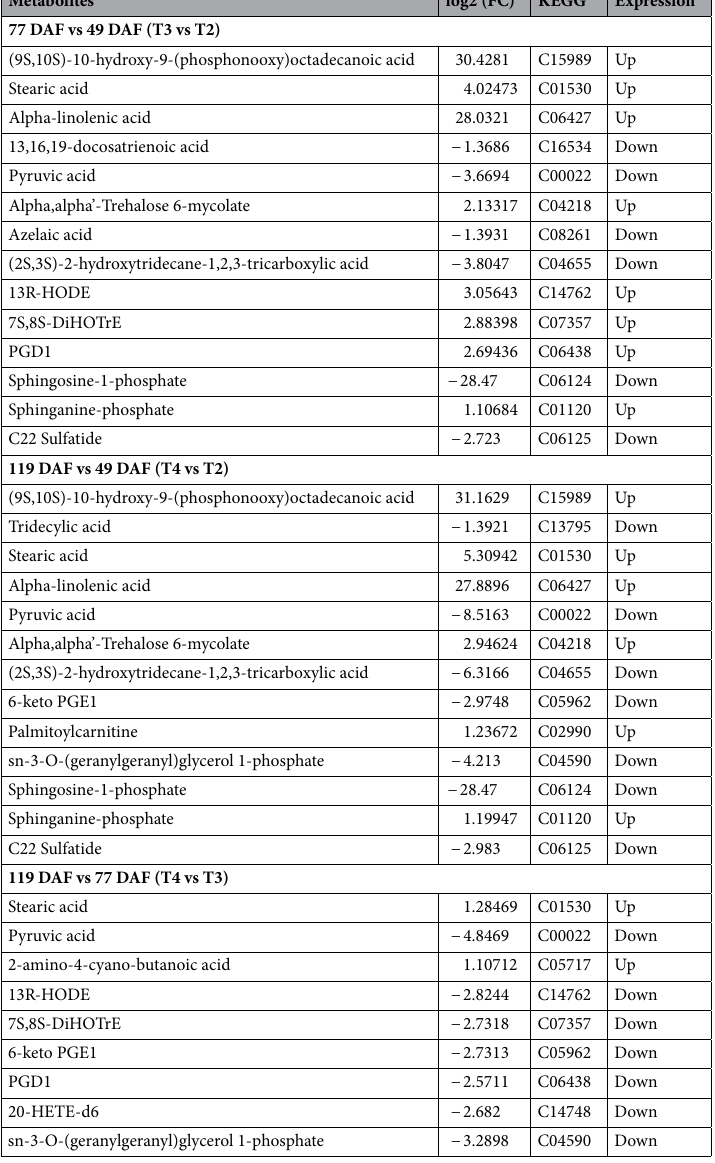
Table 3. Lipids significantly differentially abundant in the Paeonia ostii kernel throughout seed development (49–119 days after fertilization,